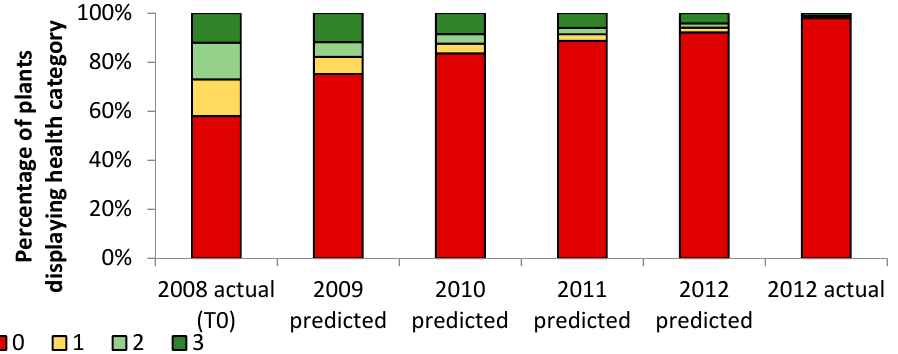
Figure 11. Predicted vigour ratings of dieback affected plants over a period of 20 years (0–25) using the Markov chain model. Health categories: 0 = dead (red), 1 = ratings 1–35 (yellow), 2 = ratings 36–74 (light green), 3 = ratings 75–100 (dark green).